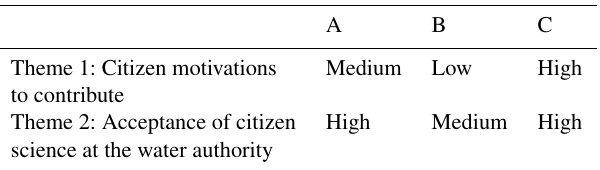
Table 3. Summary of the perception of the level of citizen motiva- tions to contribute (Theme 1) and the level of acceptance of citizen science at the water authority (Theme II) for Viewpoints A, B and C. A B C